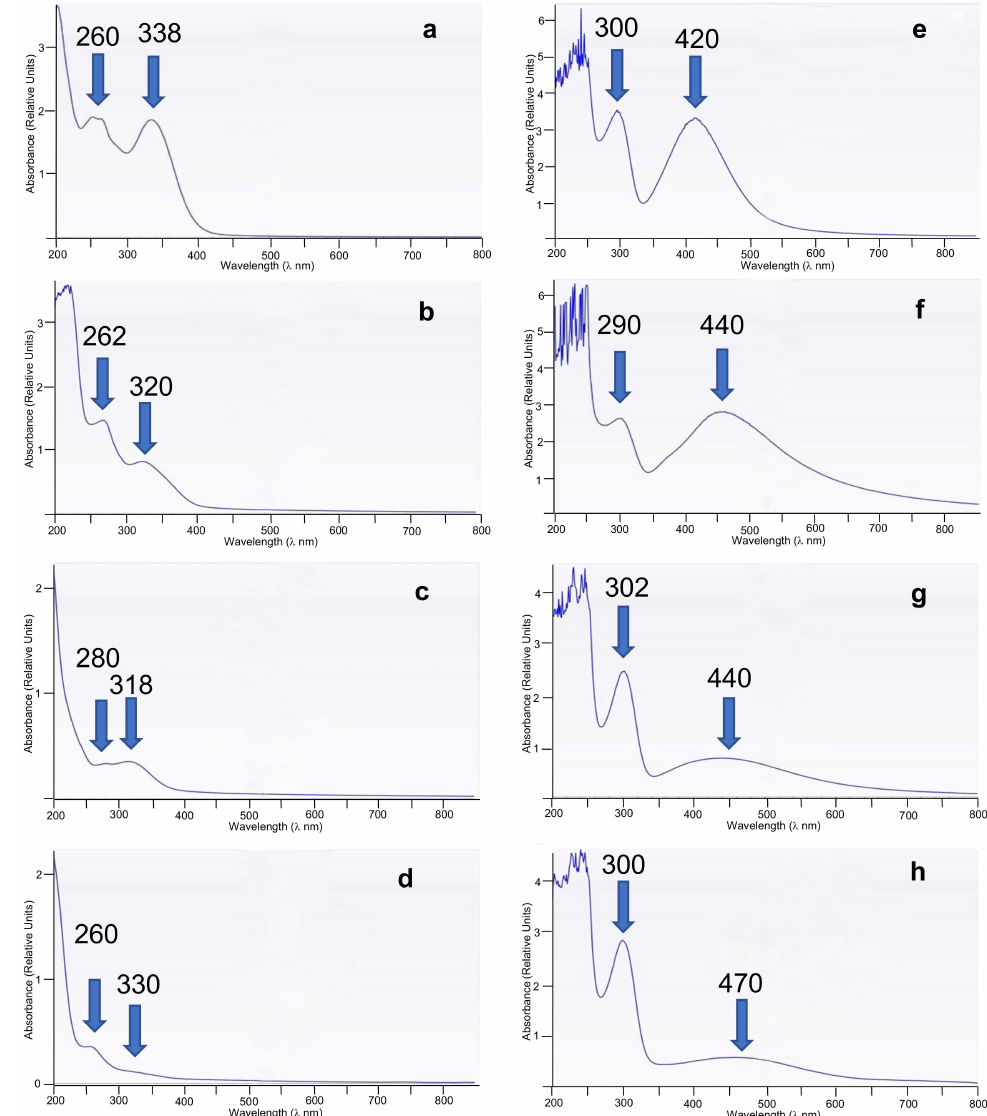
Figure 3. UV-Vis spectra ( λ in nm) of WEOP of ( a ) Bellis perennis petals (daisy), ( b ) Allium sativum peel (garlic), ( c ) Allium porrum (leek) green zone, ( d ) Allium porrum white zone; and AgNPs pre- pared from WEOP of ( e ) Bellis perennis petals, ( f ) Allium sativum peel, ( g ) Allium porrum green zone, ( h ) Allium porrum white